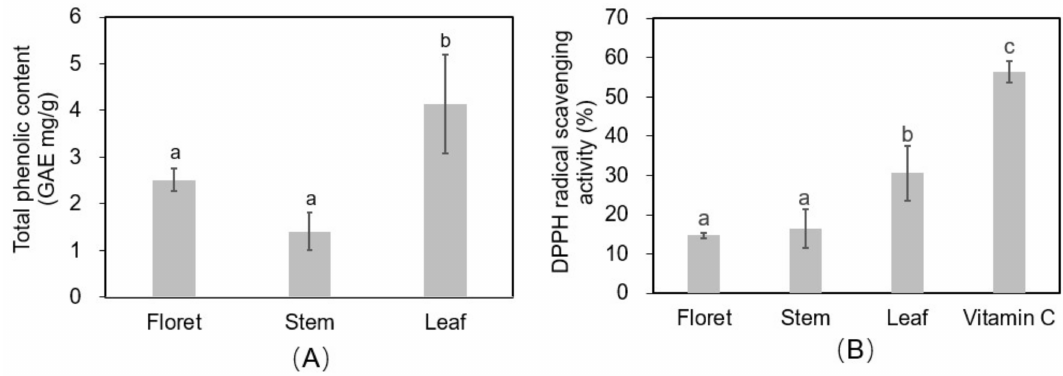
Figure 6. Total phenolic content (gallic acid equivalent (GAE) mg/g DW) ( A ) and 2,2-diphenyl-1- picryl-hydrazyl-hydrate (DPPH) antioxidant activity ( B ) in different tissues of broccoli extract (12.5 mg DW/mL of 70% methanol). Vitamin C was used as positive control (125 µ